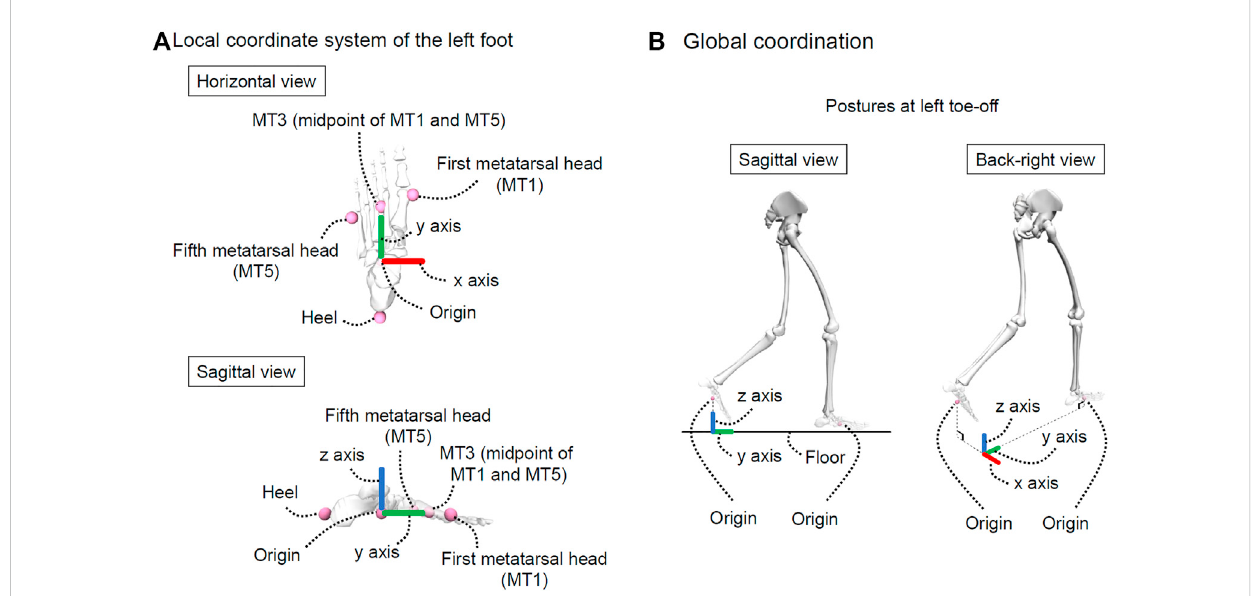
FIGURE 1 Explanation of coordinate systems. (A) represents the local coordinate system of the left foot and (B) represents the global coordination. This fi gure was created using OpenSim (Delp et al., 2007; Seth et al.,